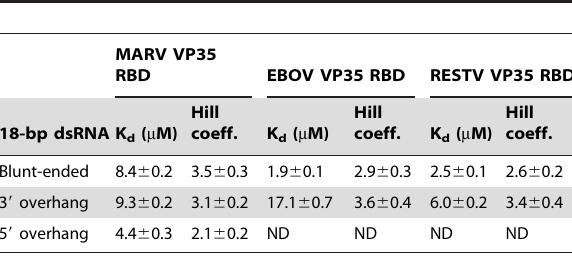
Table 3. Binding affinities and Hill coefficients of various VP35 proteins binding to